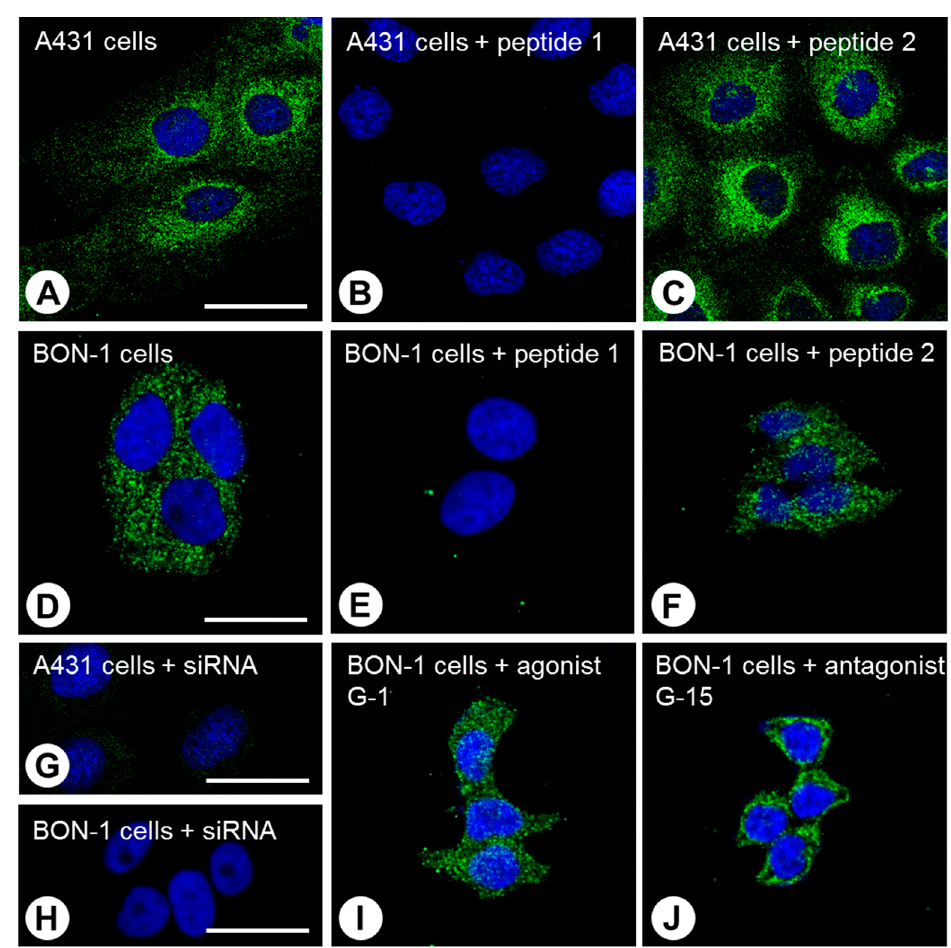
Figure 2. Immunocytochemical analysis of A431 cells and BON-1 cells endogenously expressing GPER. A431 cells ( A – C , G ) and BON-1 cells ( D – F , H – J ) were fixed and stained with the novel anti- GPER antibody 20H15L21, followed by an Alexa Fluor 488-conjugated anti-rabbit secondary antibody. For adsorption controls, the anti-GPER antibody was preincubated for 2 h with either 10 µg/mL of the peptide used for the immunisation of the rabbit (peptide 1; B , E ) or with a peptide representing an amino acid sequence at the N-terminal region of the receptor (peptide 2; C , F ). Note that after preincubation with peptide 1 but not peptide 2, a complete extinction of the immunosignal was observed. For further analysis of the specificity of the novel antibody, GPER expression was silenced in A431 and BON-1 cells using a GPER-specific siRNA. Again, a complete disappearance of the immunosignal was noted ( G , H ). In an additional set of experiments, BON-1 cells were ex- posed to either 10 µM of the selective GPER agonist G-1 or 10 µM of the selective GPER antagonist G-15 for 30 min. After agonist stimulation, intracellular distribution was retained ( I ), whereas treat- ment with the antagonist resulted in the redistribution of GPER to the plasma membrane ( J ). Green, GPER immunosignal; blue, DAPI nuclear staining. Representative results from one of three inde- pendent experiments are shown. Scale bars: ( A – C , G ) 40 µm; ( D – F , H – J ) 20 µm. GPER, G protein-